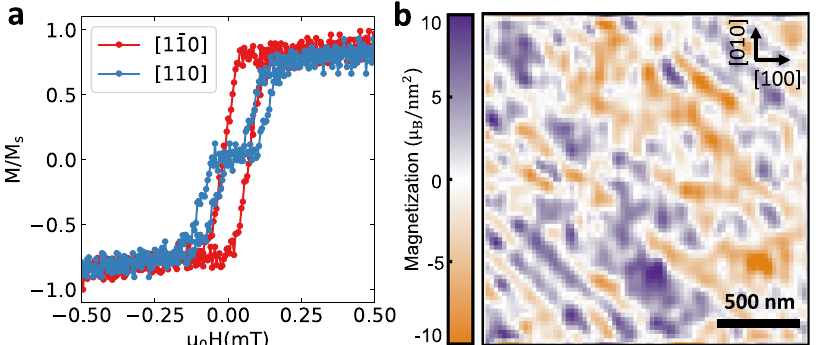
Fig.1|MagnetichysteresisandimagingofmagnetizationwiththescanningNV magnetometryforMAFOthin fi lms.a Magnetichysteresisloopsmeasuredwitha SQUID magnetometer for a 6nm MAFO fi lm, which is the same fi lm used for nonlocal spin transport measurements. The magnetic fi eld is swept along the in-